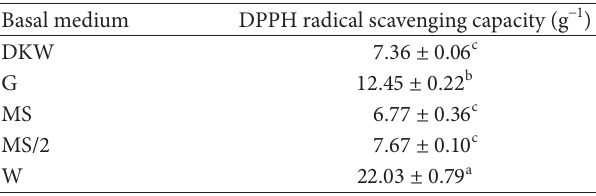
Table 4: Effect of basal media formulations on DPPH radical scavenging capacity of C. heterophyllus after 4 weeks of culture in liquid media.